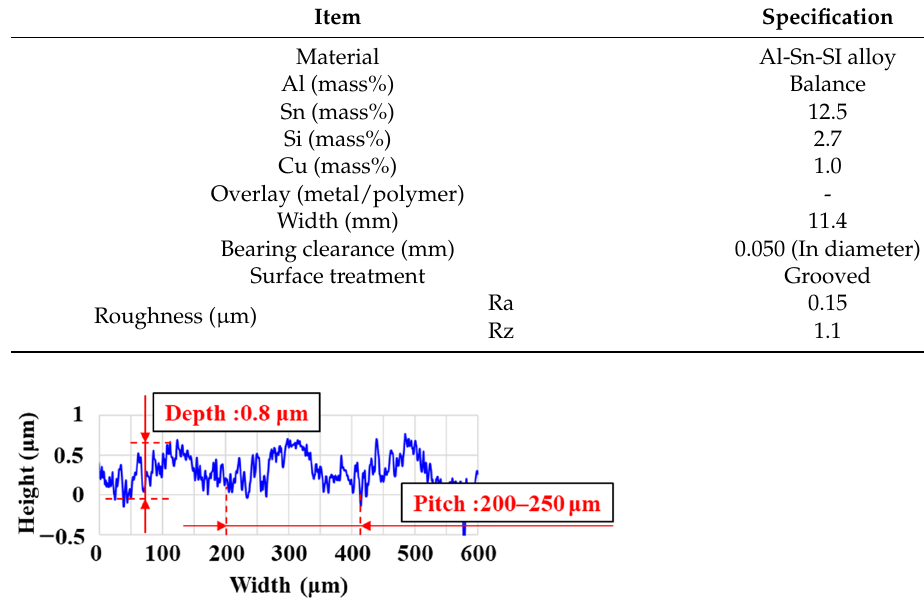
Figure 7. Measured results for bearing surface grooves.